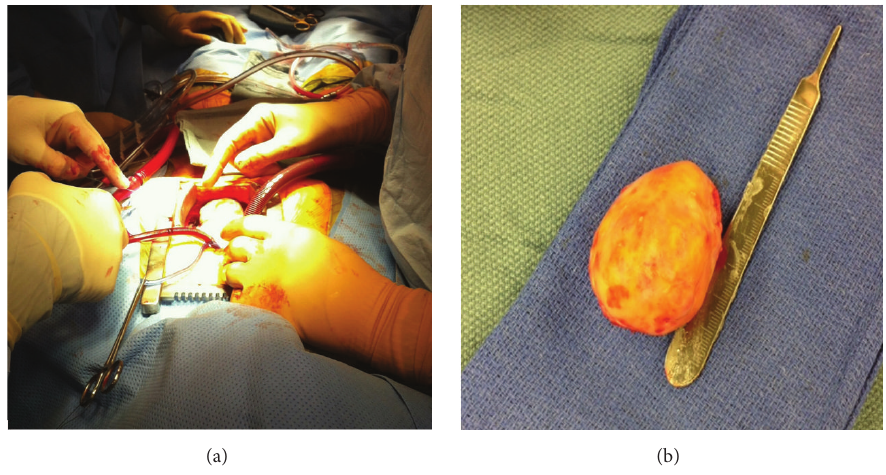
Figure 2: Gross image of the cardiac mass measuring 5.5 × 4.0 × 3.5